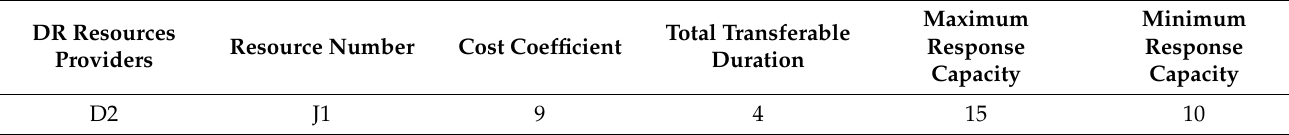
Table A4. Transferable load characteristic parameter.